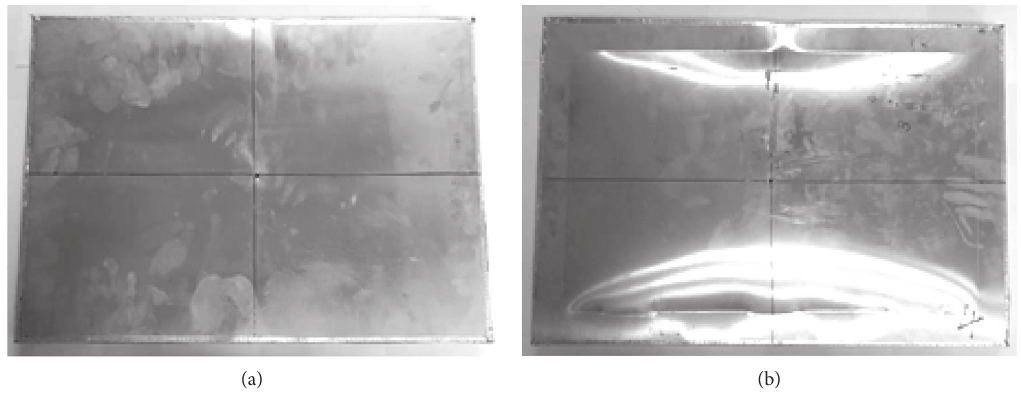
Figure 20: Front view of ST4 deformation situation. (a) Explosion-facing panel. (b) Explosion-back panel.